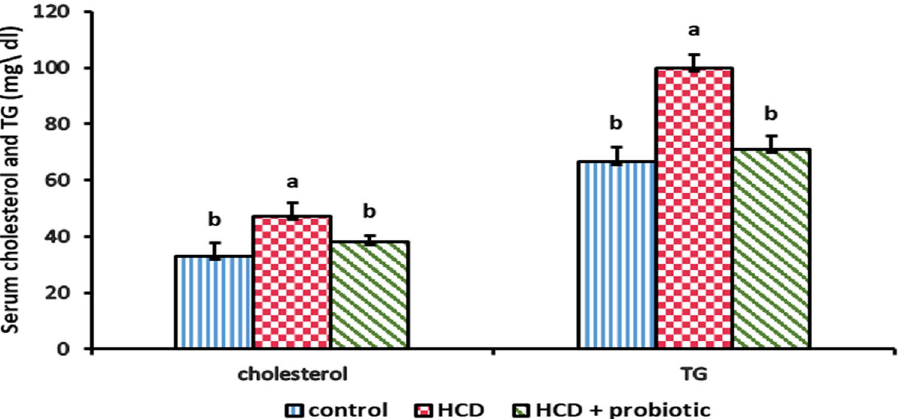
Figure 8. Effect of HCD supplementation and HCD with probiotic on lipid profile [cholesterol and Triglyceride